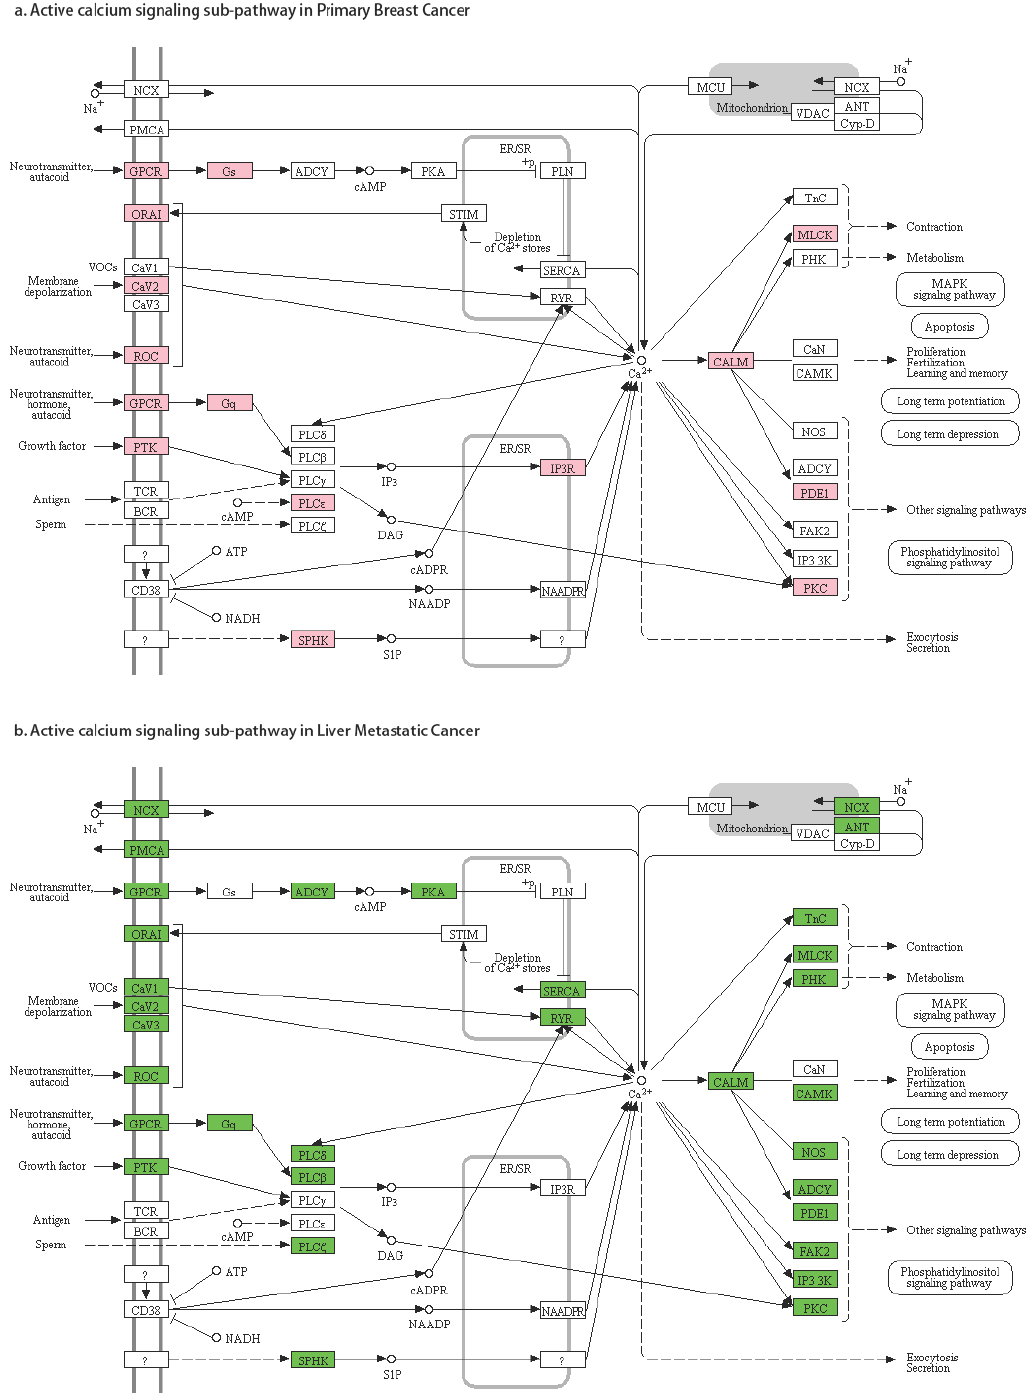
Figure 6. Gene activities in the calcium signaling pathway.